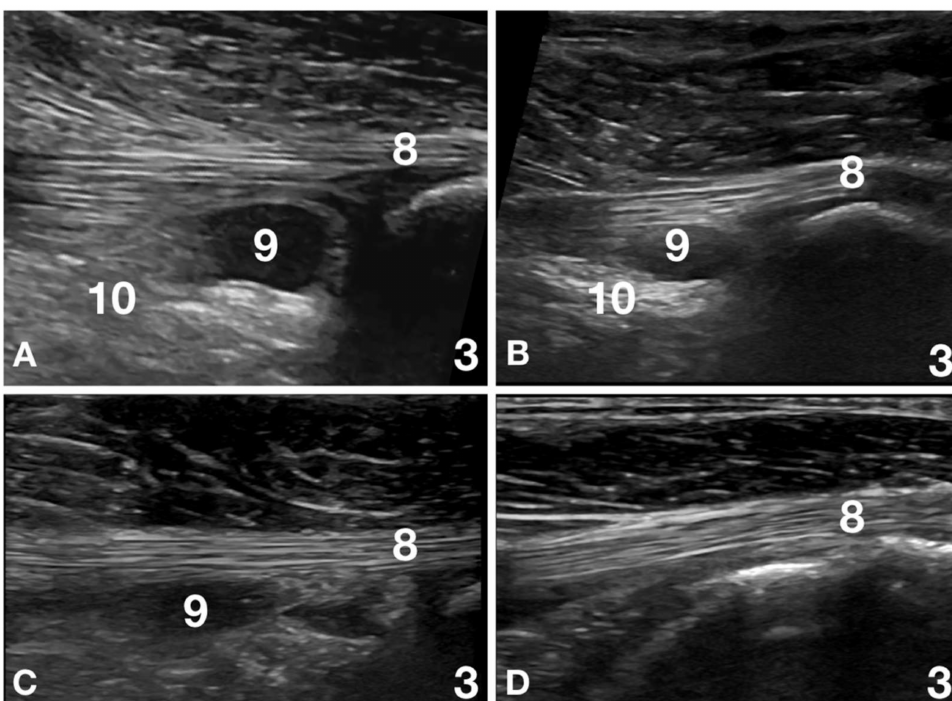
Figure 3. Images of the left shoulder at the level of the infraspinatus muscle and tendon insertion of patient number 18 at Time 0, Time 2, Time 4 and Time 6 are reported. ( A ) Time 0: the infraspinatus tendon (8) is thin and relatively ill-defined at its humeral insertion (3). A large anechoic area (9) surrounded by scattered artefacts (10) is seen in the region of the teno-muscular junction. This lesion was considered a muscle rupture and was differentiated by an enlarged infraspinatus bursa due to the size, location and scattered artefacts associated with acute inflammation. The severe pain at palpation of the region was another element that helped to differentiate the pathology from normal anatomy. ( B ) Time 2: the infraspinatus tendon (8) is thin as compared with the contralateral limb but is better defined with a more pronounced fibrillar pattern. The anechoic area (9) is reduced in size, and the associated scattered artefacts (10) are also reduced. Mild pain was still present on palpation. ( C ) Time 4: the infraspinatus tendon (8) has nearly the same diameter as the contralateral limb. The fibrillar pattern is compact and shows good alignment. The anechoic area (9) is reduced in size, more difficult to see, lacks well-defined margins, and is not associated with scattered artefacts. No pain was present on palpation. ( D ) Time 6: the infraspinatus tendon (8) shows the same diameter and fibrillar pattern as the contralateral limb. The anechoic area (9) is no longer visible and is not associated with scattered artefacts. No significant differences with the contralateral limb are visible. No pain was present on